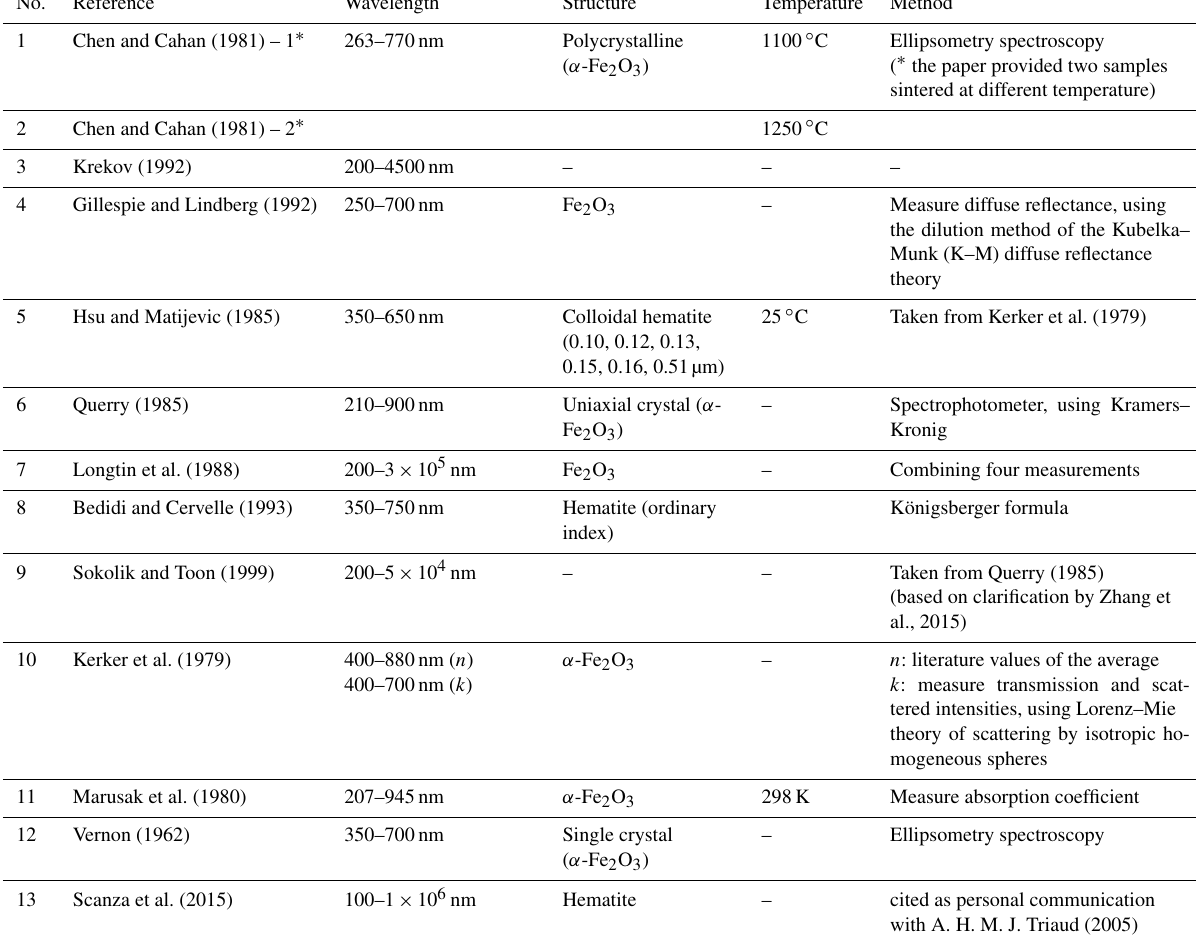
Table 1. Summary of hematite refractive index information used in Fig. 3.